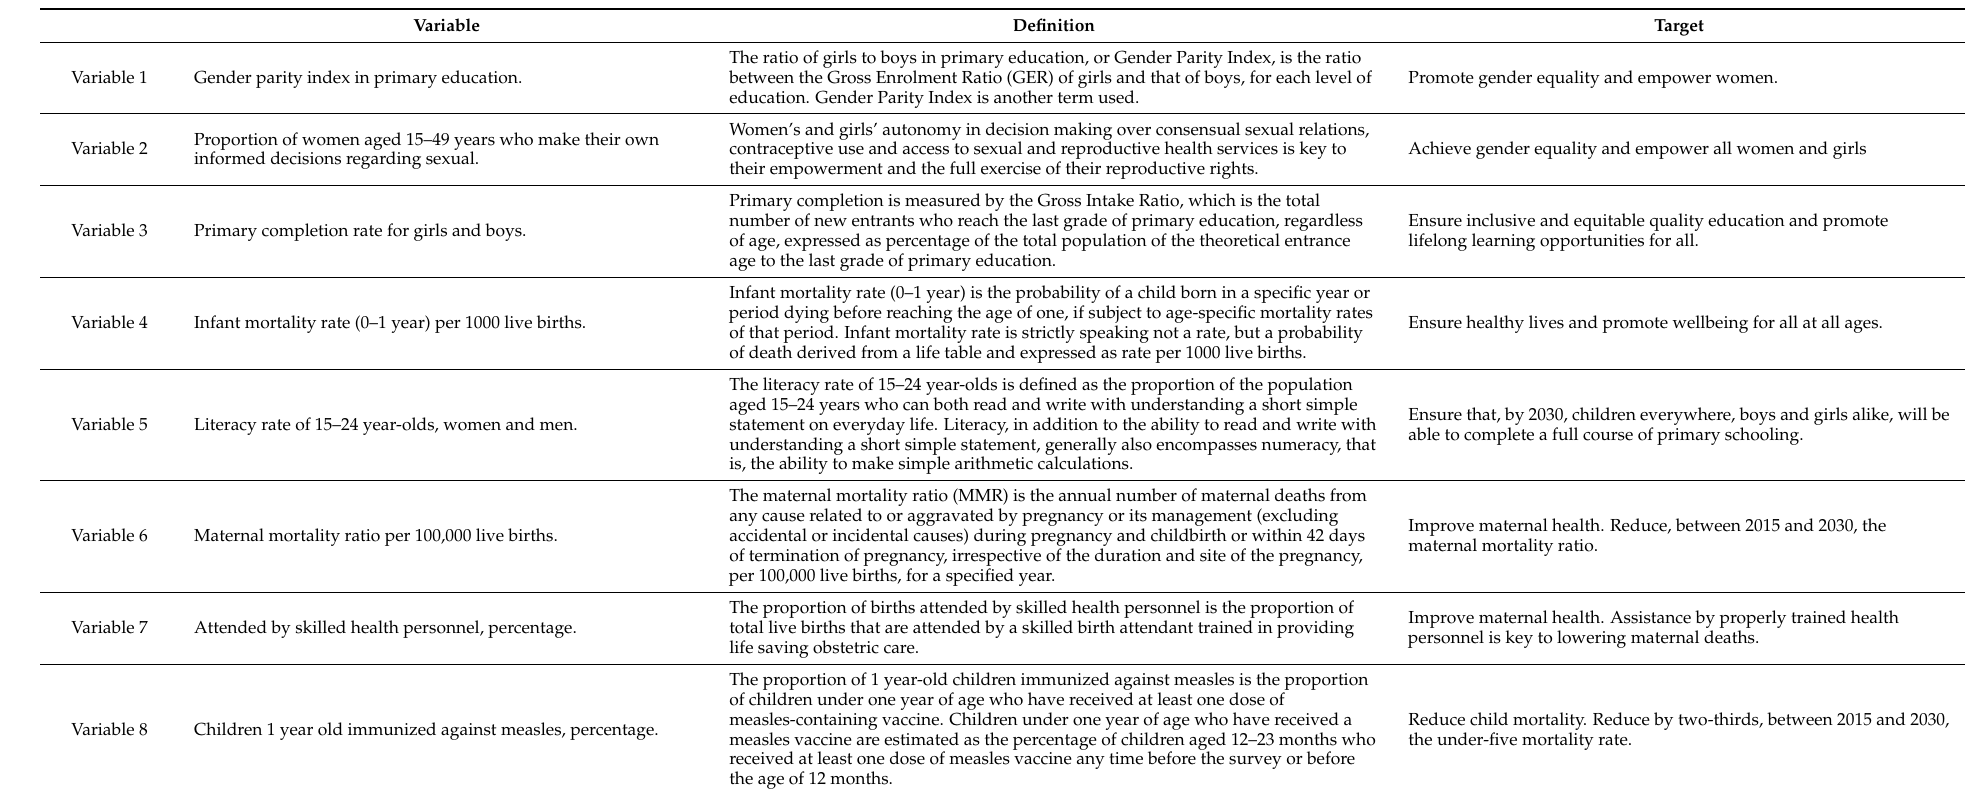
Table A1. Detailed description of proposed variables